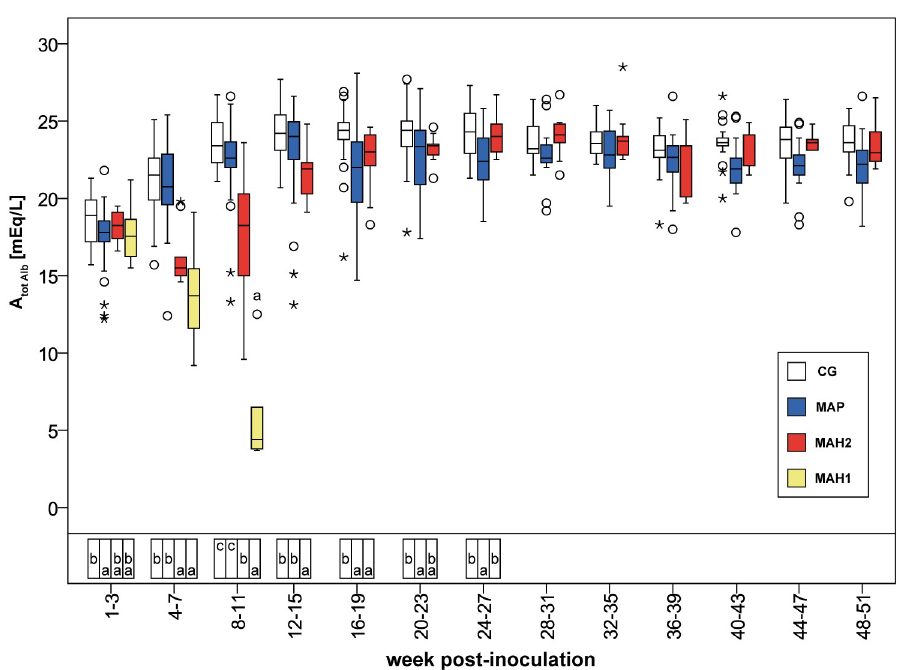
Fig 4. Calculated acid total based on albumin in mEq/L assessed in venous blood. CG, control group. MAP, group infected with Mycobacterium avium subsp. paratuberculosis . MAH 1, sub-group infected with Mycobacterium avium subsp. hominissuis with acute, severe form of infection. MAH 2, sub-group with chronic form of infection. Different letters indicate significant differences between groups within one period (Mann-Whitney U -test, P < 0.05). n.s., no significant differences between groups in the given period. From 28 th week onwards Mann-Whitney U -test was not performed due to reduced numbers of observations. Significant differences within groups (Friedman test, P < 0.05) from 1 st -3 rd to 24 th -27 th wpi are given in S3–S5, and S10 Tables.